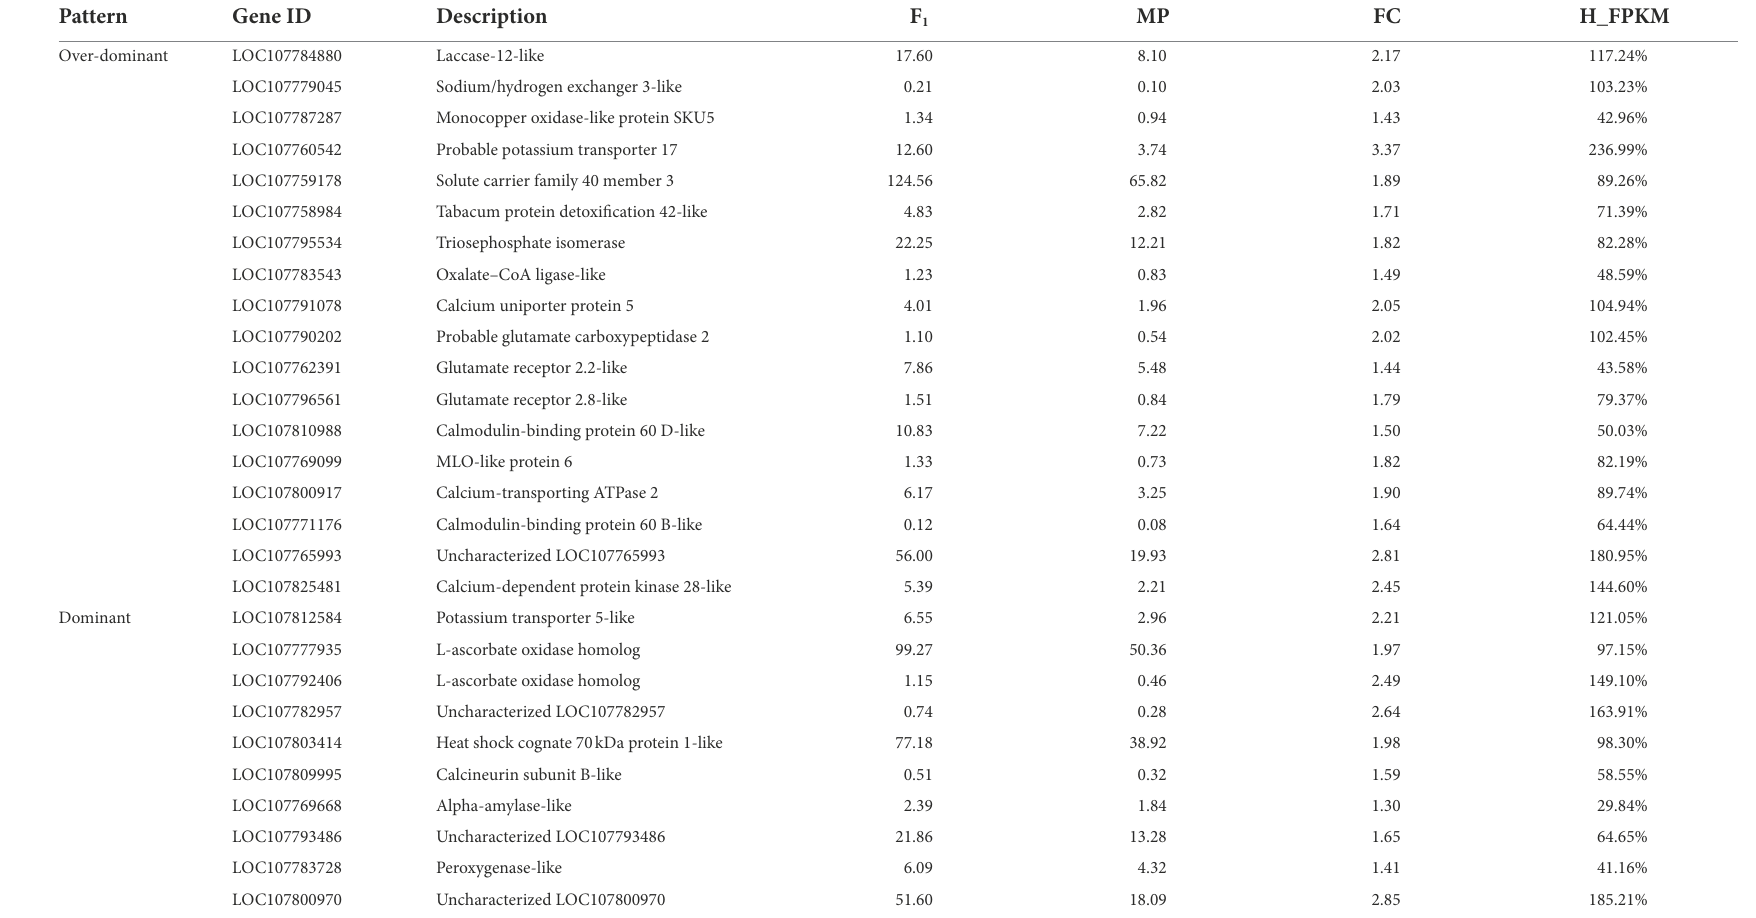
TABLE 3 Statistics of genes related to potassium content heterosis. Pattern Gene ID Description F 1 MP FC H_FPKM Over-dominant Laccase-12-like